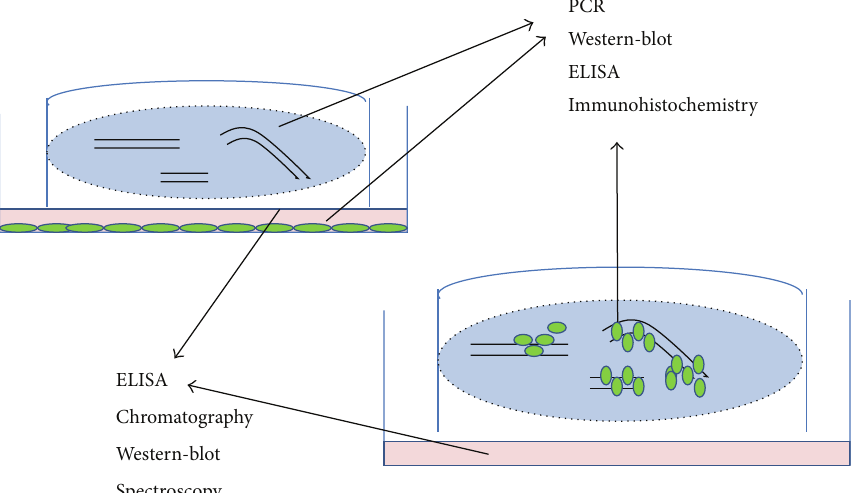
Figure 5: Possible applications of spinal cord organotypic slice culture. Spinal cord tissue after both direct and indirect cocultures with stem cells could be analyzed with immunohistochemical and molecular (PCR, Western-blot, ELISA, chromatography, and spectroscopy)